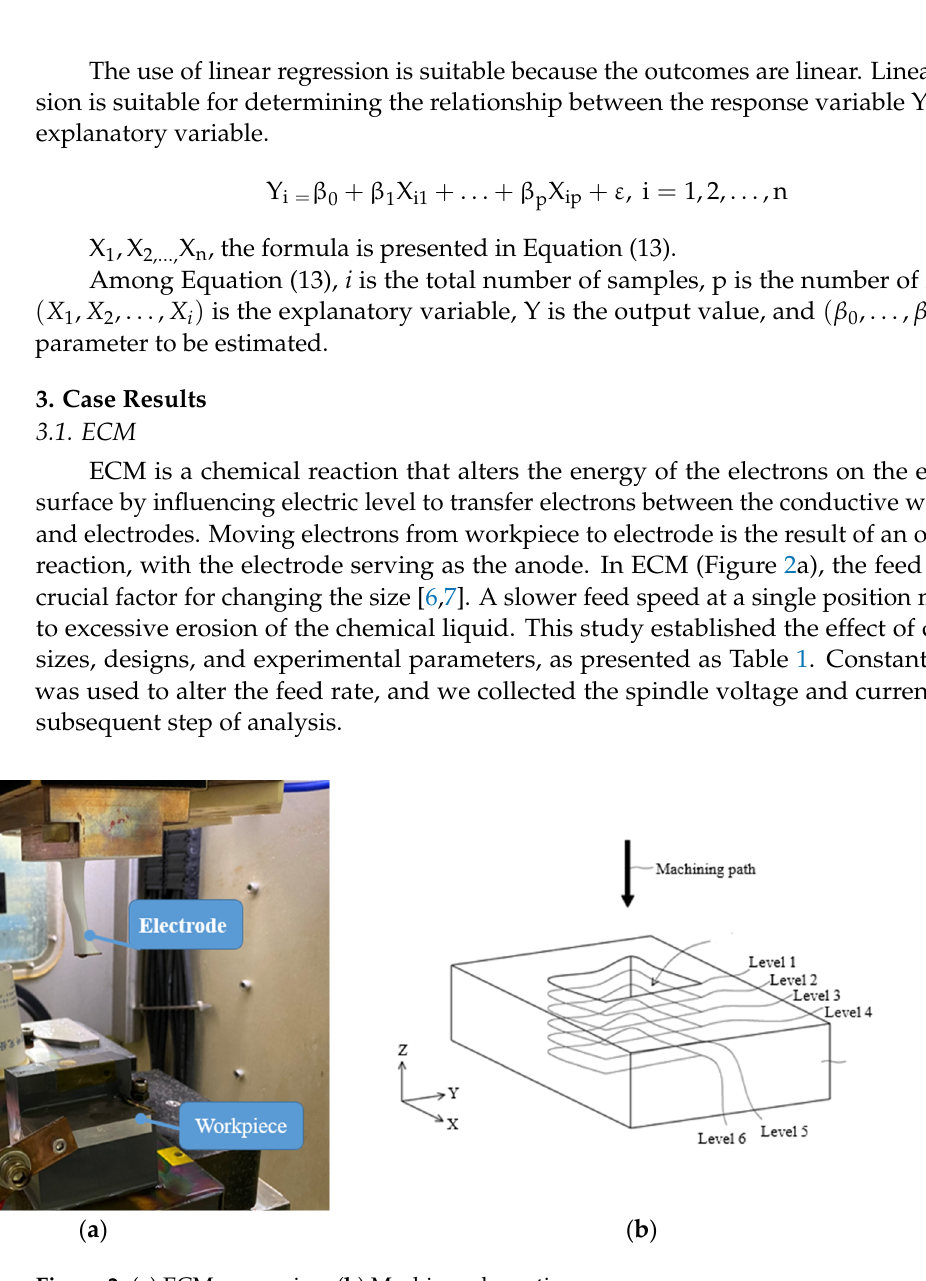
Table 1. ECM Experiment.